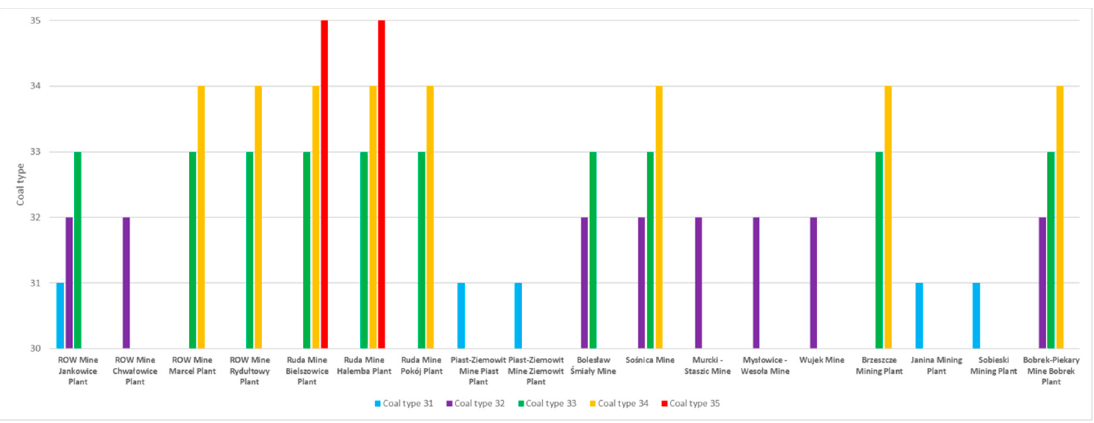
Figure 6. Types of coal mines in terms of the possibility of their use for the purpose of UCG.